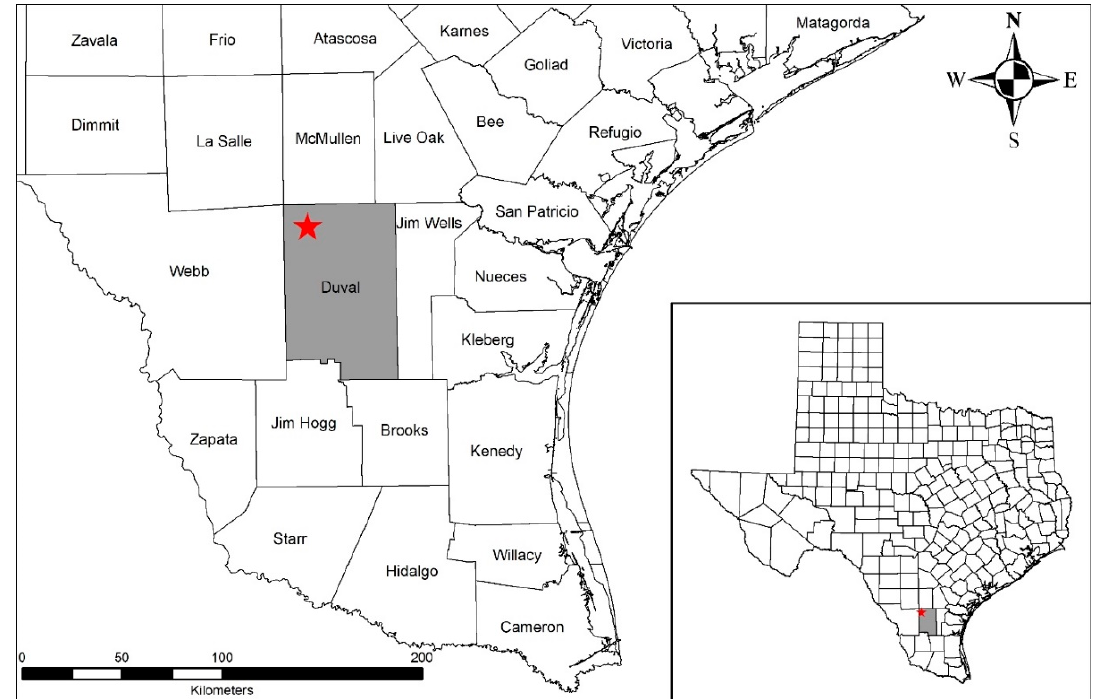
Figure 1. Study site location on Duval County Ranch, NW Duval County, TX.